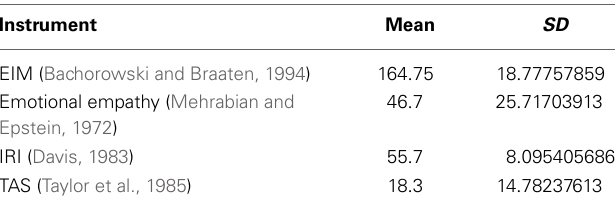
Table 2 | Participant characteristics in terms of emotional sensitivity, empathy, and